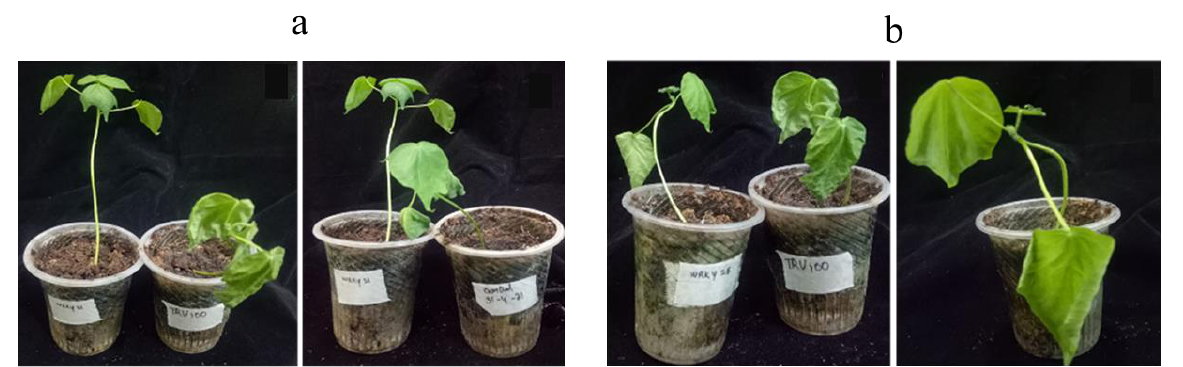
Figure 6. Drought bioassay on cotton VIGS-infiltrated plants. (a) Non-infiltrated, TRV:TRV2- WRKY33-, and TRV:00-infiltrated cotton plants at 30 th day of drought stress. ( b ) TRV:TRV2- WRKY33-, and TRV:00-infiltrated cotton plants at 30th day of drought stress. ( b ) TRV:TRV2-WRKY25- and TRV:00-infiltrated cotton plants at 30th day of drought WRKY25- and TRV:00-infiltrated cotton plants at 30 th day of drought stress.